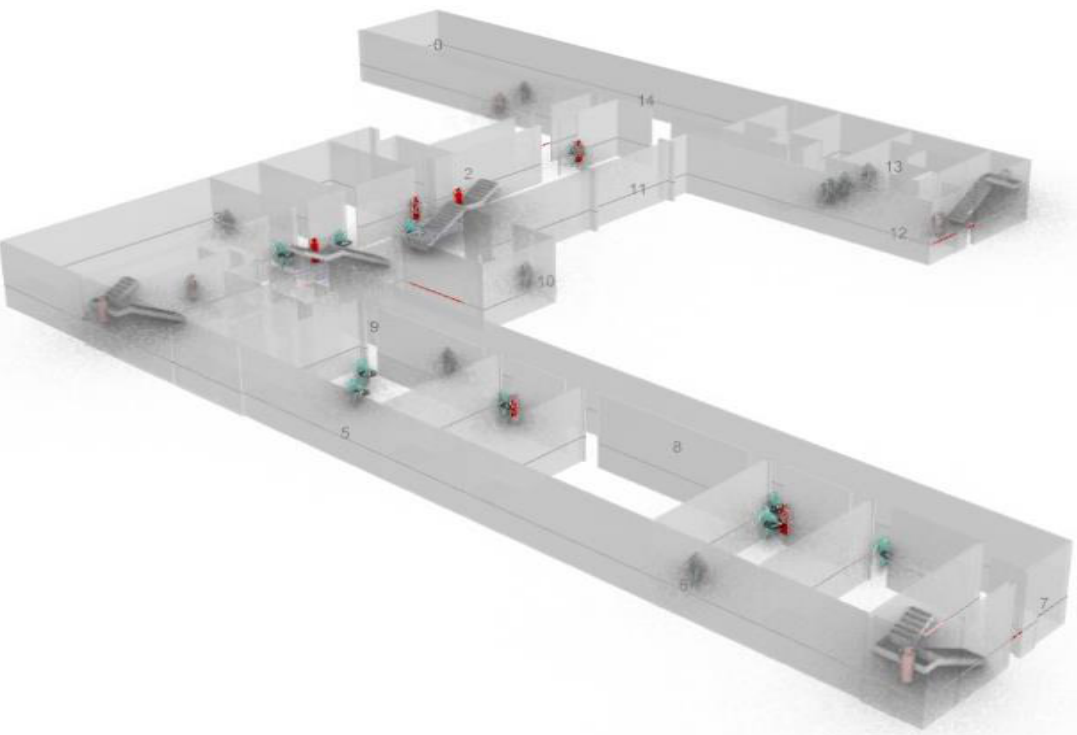
Figure 7. 3D-BIM Model of the con-fire safety planning simulation